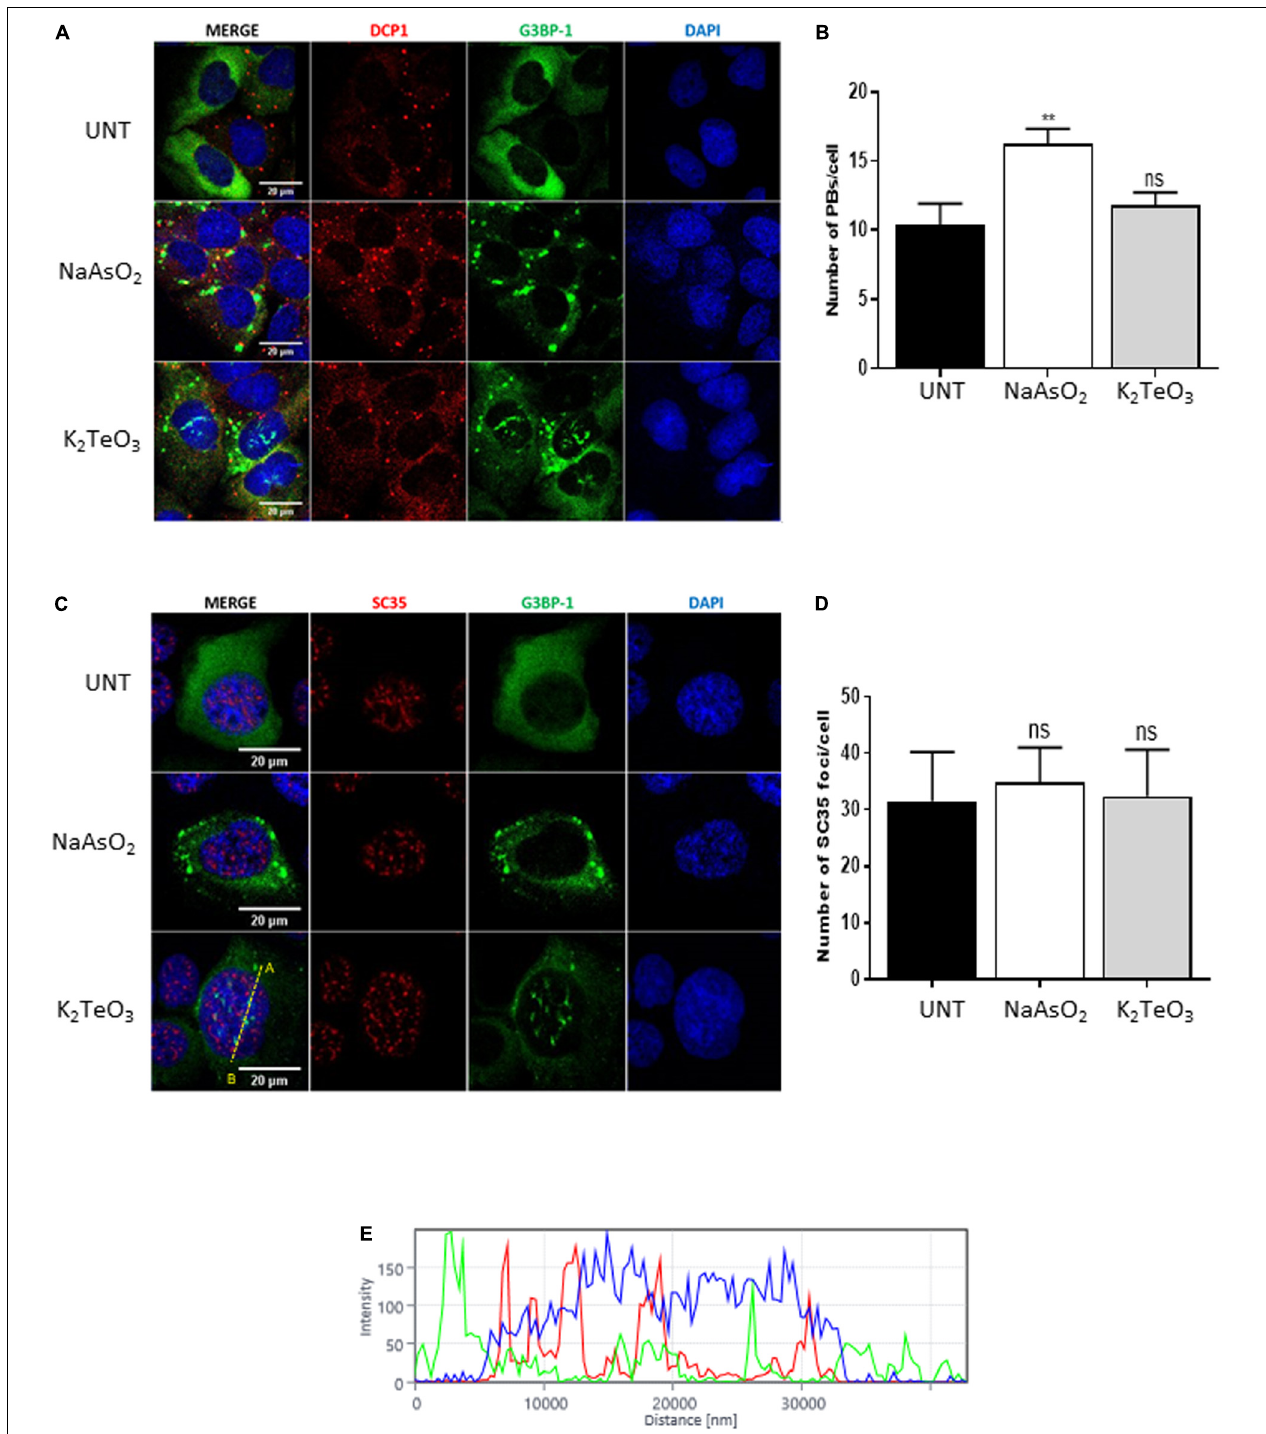
FIGURE 4 | Tellurite does not affect PBs nor nuclear speckles. (A) U2OS GFP-G3BP-1 cells were treated with 0.3 Mm of arsenite (NaAsO 2 ) for 1 h or with 0.6 mM tellurite (NaAsO 2 ) for 3 h and subsequently immunostained for DCP1 (red). Nuclei were stained with DAPI (blue). (B) Quantification of the average PBs per cell in untreated cells or in the presence of 0.6 mM tellurite (K 2 TeO 3 ) or 0.3 mM arsenite (NaAsO 2 ). Data represented as means ± SD (** p < 0.01 relative to untreated cells by unpaired t -test). (C) U2OS GFP-G3BP-1 cells were treated with 0.3 Mm of arsenite (NaAsO 2 ) for 1 h or with 0.6 mM tellurite (K 2 TeO 3 ) for 3 h. Cells were fixed and immunostained for SC35 (red). Nuclei were stained with DAPI (blue). (D) Quantification of the average SC35 foci per cell in untreated cells or in the presence of 0.6 mM tellurite (K 2 TeO 3 ) or 0.3 mM arsenite (NaAsO 2 ). Data represented as means ± SD (** p < 0.01 relative to untreated cells by unpaired t -test). (E) Histogram of fluorescence intensity from A to B (indicated in C ) in the nucleus.